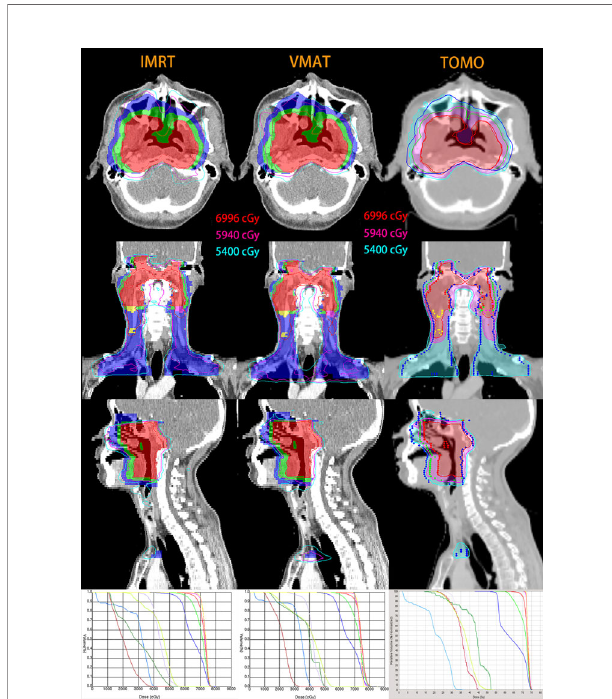
FIGURE 2 | Isodose distributions and dose-volume histograms (DVHs) for a representative T 4 -stage NPC patient with IMRT (left), VMAT (middle) and TOMO (right) planning. Maroon, forest, lavender, yellow-green, light-blue, red, green and blue lines in three DVH are optic nerve in left, optic nerve in right, optic chiasma, brain stem, spinal cord, PGTVnx, PCTV-1 and PCTV-2, respectively. For IMRT and VMAT planning, color-wash areas: PGTVnx (red), PGTVnd-left (purple), PGTVnd-right (yellow), PCTV-1 (green), PCTV-2 (blue); and the red, purple and sky-blue lines are isodose curves of 69.96Gy, 59.4Gy and 54Gy. For TOMO planning, isodose curves of 69.96Gy, 59.4Gy and 54Gy are shaded in the red, purple and sky-blue, respectively; targets are represented by lines: PGTVnx (red), PGTVnd-left (purple), PGTVnd-right (yellow), PCTV-1 (green), PCTV-2